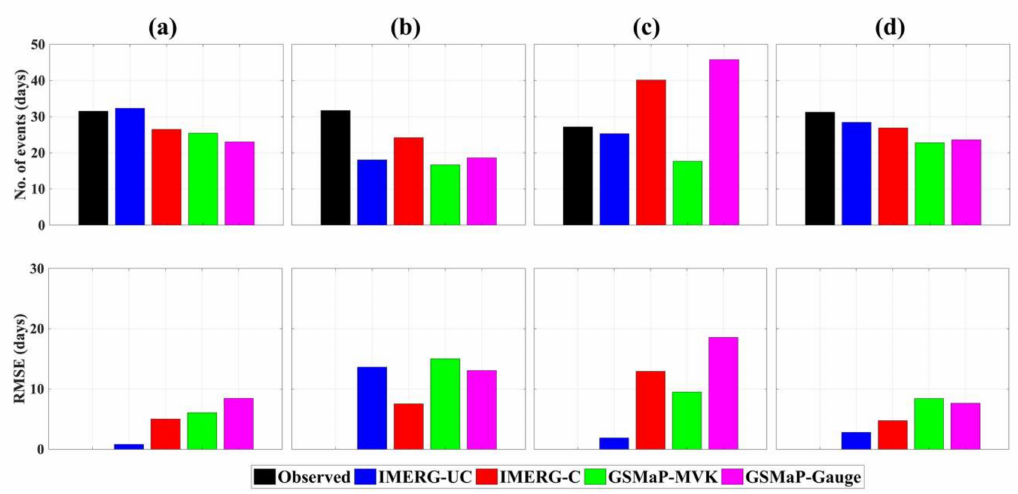
Figure 8. Bar charts showing extreme events (mean number of days) and RMSE (mean number of days) in the gauge observed data and four SBP datasets from 2015 to 2016 for ( a ) low-elevation (below 1500 m), ( b ) mid-elevation (between 1500 and 2500 m), ( c ) high-elevation (above 2500 m), and ( d ) the whole